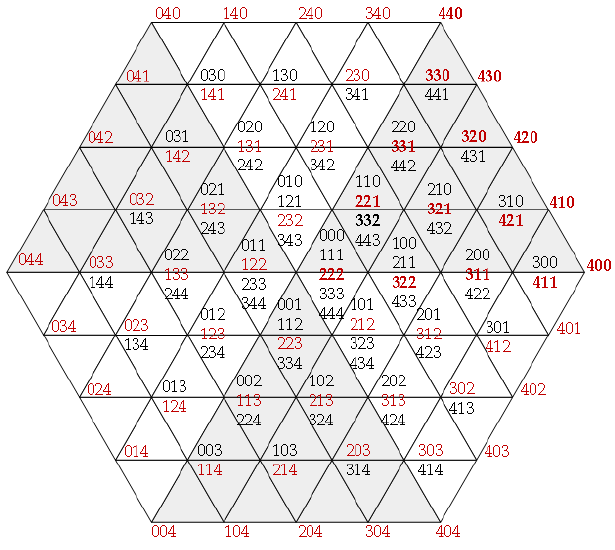
Figure 3. The space vector diagram of the five-level MMC upper bridge arm. Table 2. The number of CMVs by five-level